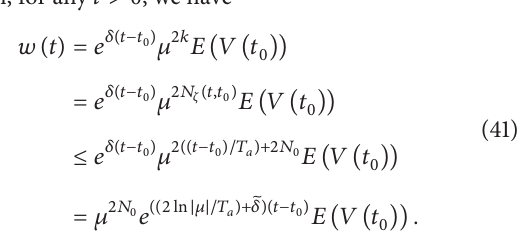
Similar procedures in (19) and (20)